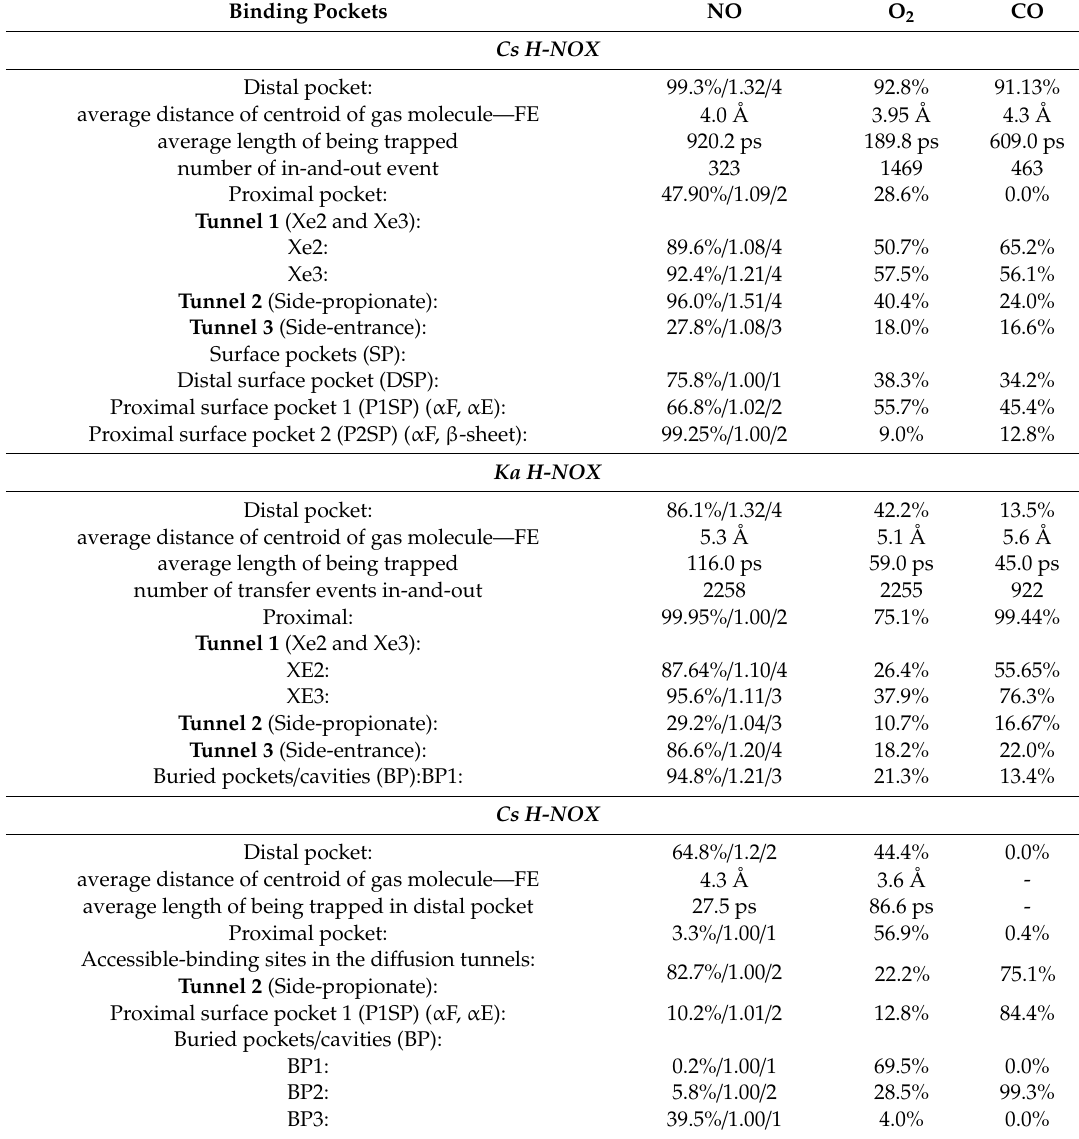
Table 3. Identified binding cavities in Ns / Ka / Cs H-NOX systems. Occupancy by at least one ligand molecule over the trajectory is given in %. In the case of the NO-containing systems, the average number and the observed maximum number of NO molecules in the pockets are also shown. For the distal pockets further information is given. The spatial distribution of the pockets is depicted in Figure